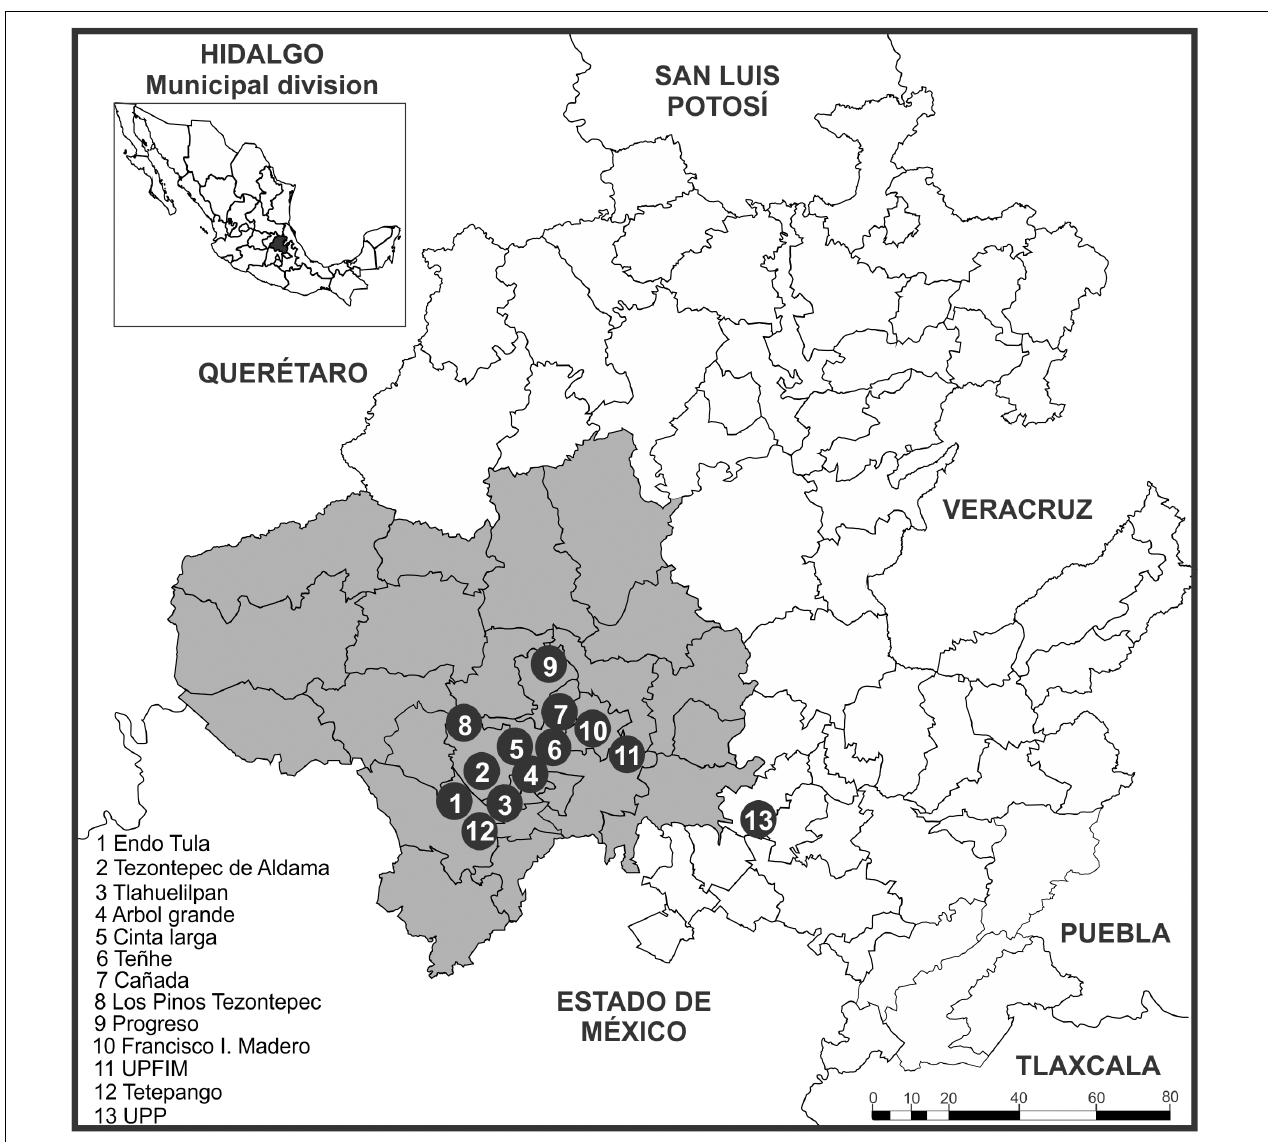
FIGURE 1 | Map of the municipal divisions and geographic location of Valle del Mezquital (gray). Circles with numbers indicate the sites where biological material was collected (INEGI,